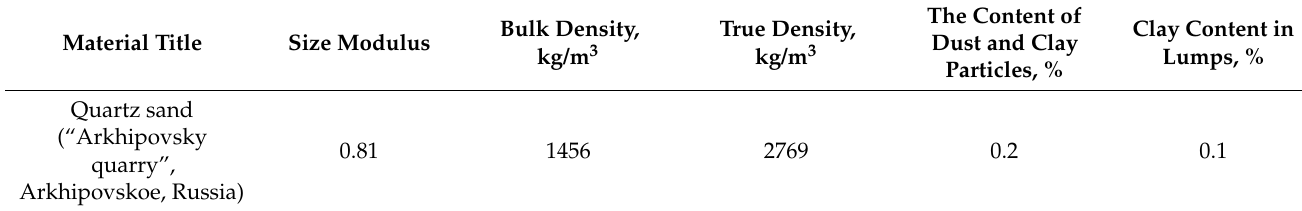
Table 2. Physical characteristics of